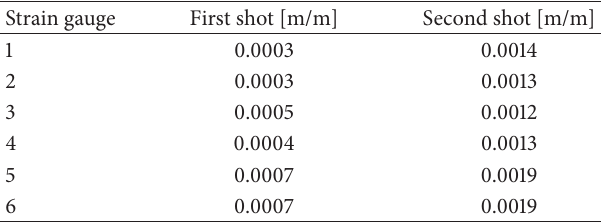
Table 2: Maximum absolute GFRP pipe strains during blast tests. Strain